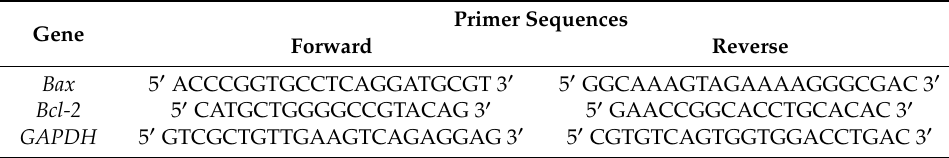
Table 3. Primer sequences for real-time PCR